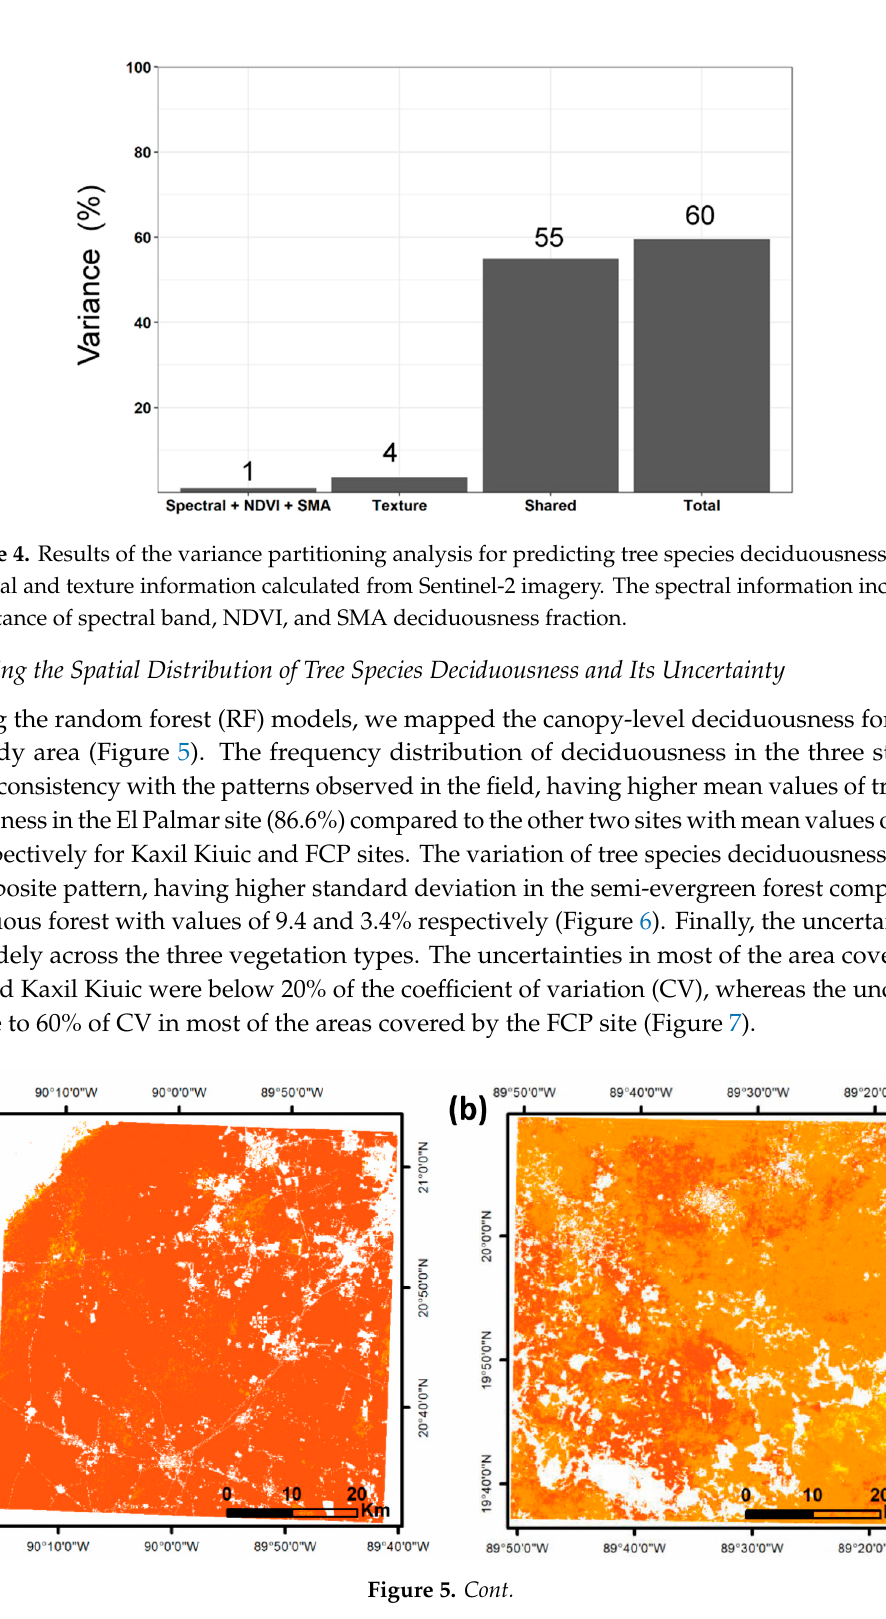
Figure 5. Maps of tree species deciduousness for each vegetation type: ( a ) deciduous (El Palmar), ( b ) semi-deciduous (Kaxil Kiuic), and ( c ) semi-evergreen (Felipe Carrillo Puerto: FCP). Areas in white correspond to non-forest covers, mostly agricultural lands and human settlements. Figure 6. Frequency distribution of estimated tree species deciduousness in a 3600 km 2 window of three types of tropical dry forest: deciduous ( a ), semi-deciduous ( b ), and semi-evergreen ( c ).